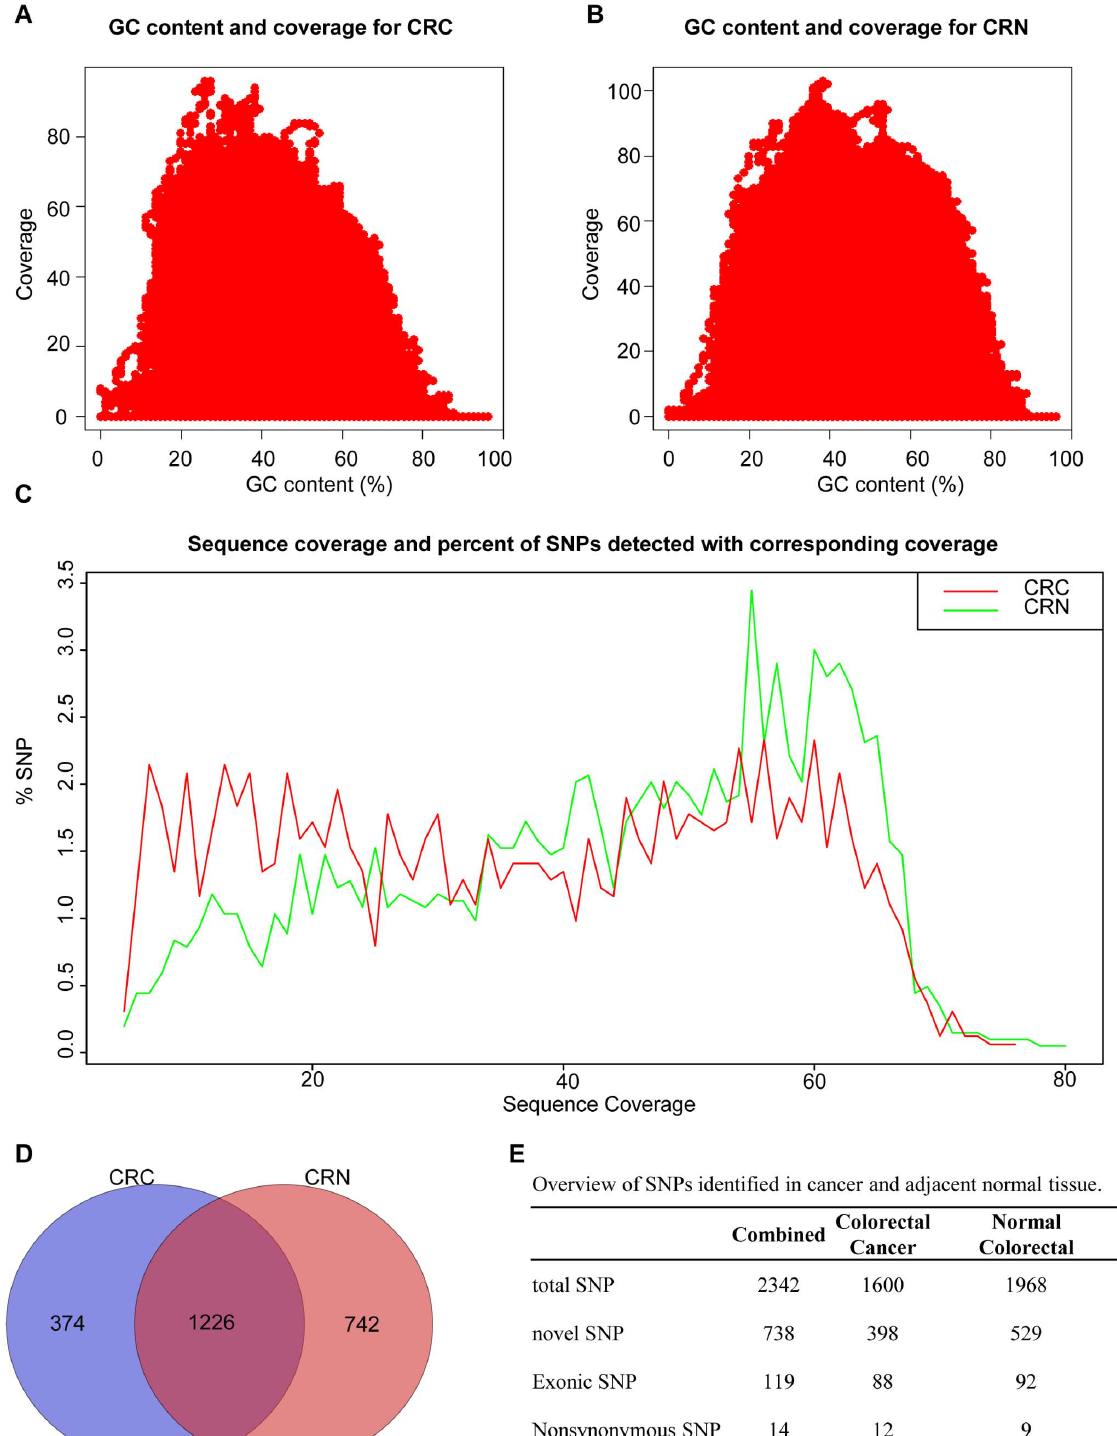
Figure 1. GC content, coverage and SNP count. (A) The GC content and coverage in CRC (colorectal cancer) tissue. (B) The GC content and coverage in CRN (colorectal normal tissue) tissue. (C) The relationship between sequence coverage and SNP detection. Red line shows the sequence coverage and percentage of SNPs detected at that coverage in CRC pool, and green line in CRN pool (D) Venn diagram of SNPs for CRC and CRN samples. (E) An overview of SNPs identified in cancer and adjacent normal tissue.